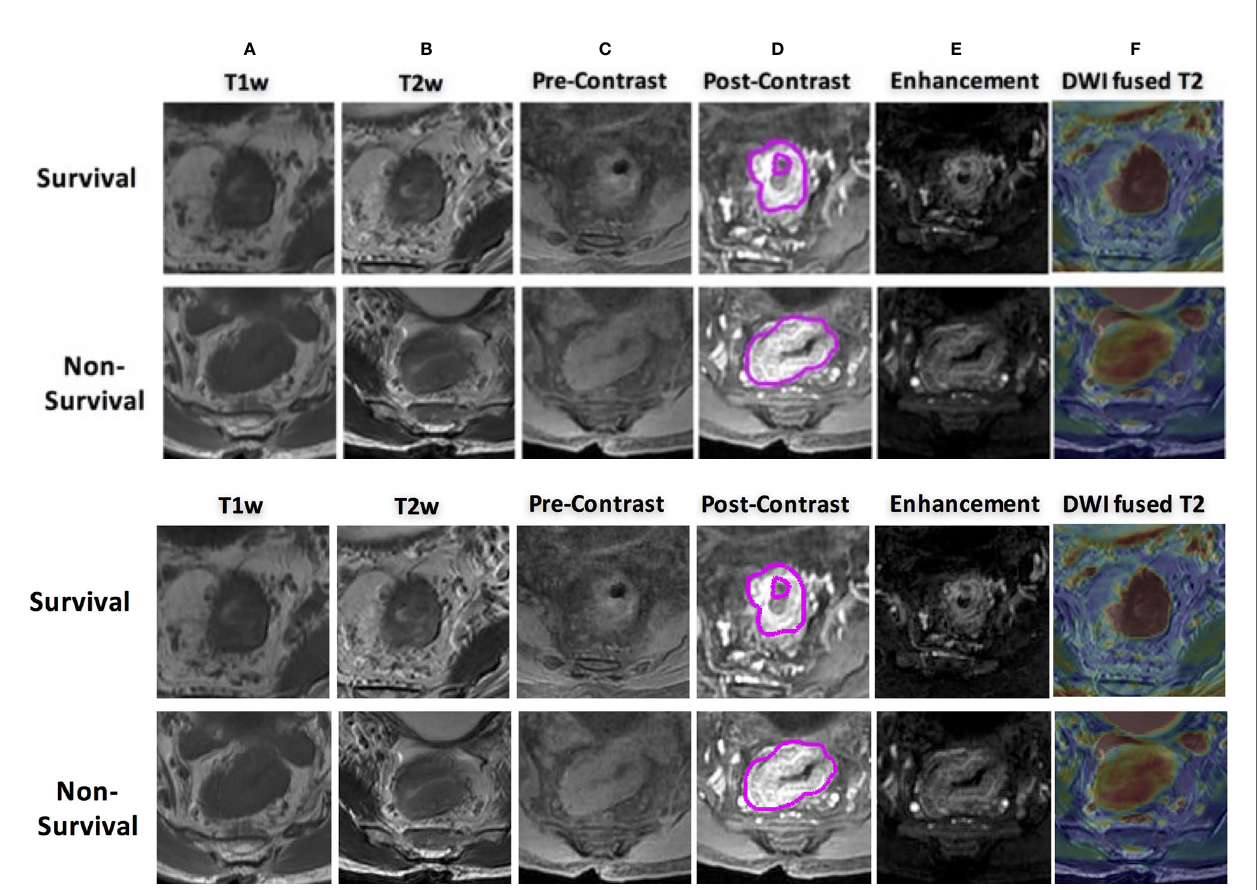
FIGURE 2 | MR images of two male patients, both at 60 years old with mid-rectum cancer at stage cT3N+M0, pretreatment (A) T1-weighted image, (B) T2- weighted image, (C) precontrast image, (D) 60 s after contrast injection image, (E) subtraction image showing difference between panels (D, C, F) the derived apparent ADC map fused to a T2-weighted image. The fi rst row shows a case as 5-year survival patient, and the bottom shows a non-survival